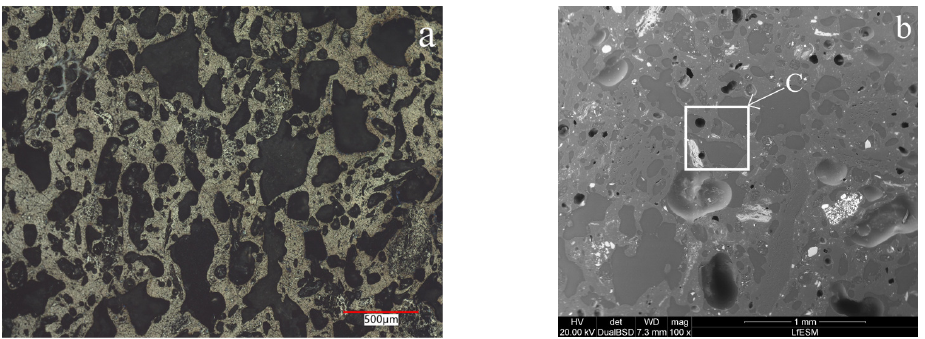
Figure 4. Images of the coke sample. ( a ) Optical image of the coke sample, magnification 100 × ; ( b ) SEM image of the coke sample with a spot of the EDS spectrum (C), magnification 100 × .